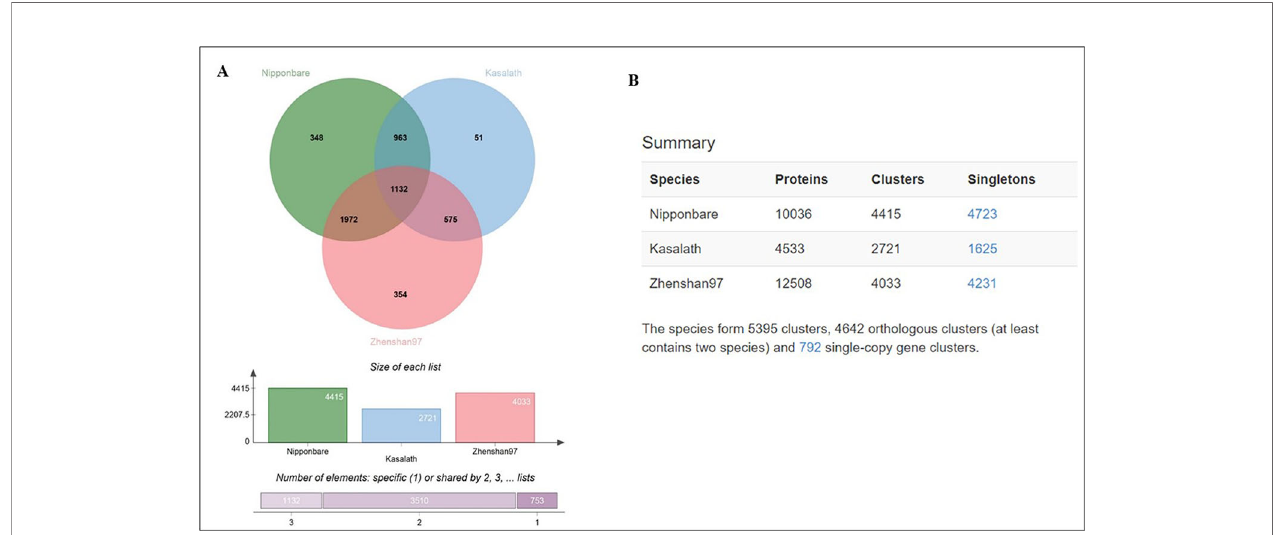
FIGURE 4 | Ortho Venn diagram. (A) Venn diagram showing the distribution of shared gene families among Nipponbare, Kasalath, and Zhenshan 97. Speci fi c gene clusters are indicated within the three reference genomes. (B) Counts of clusters in each